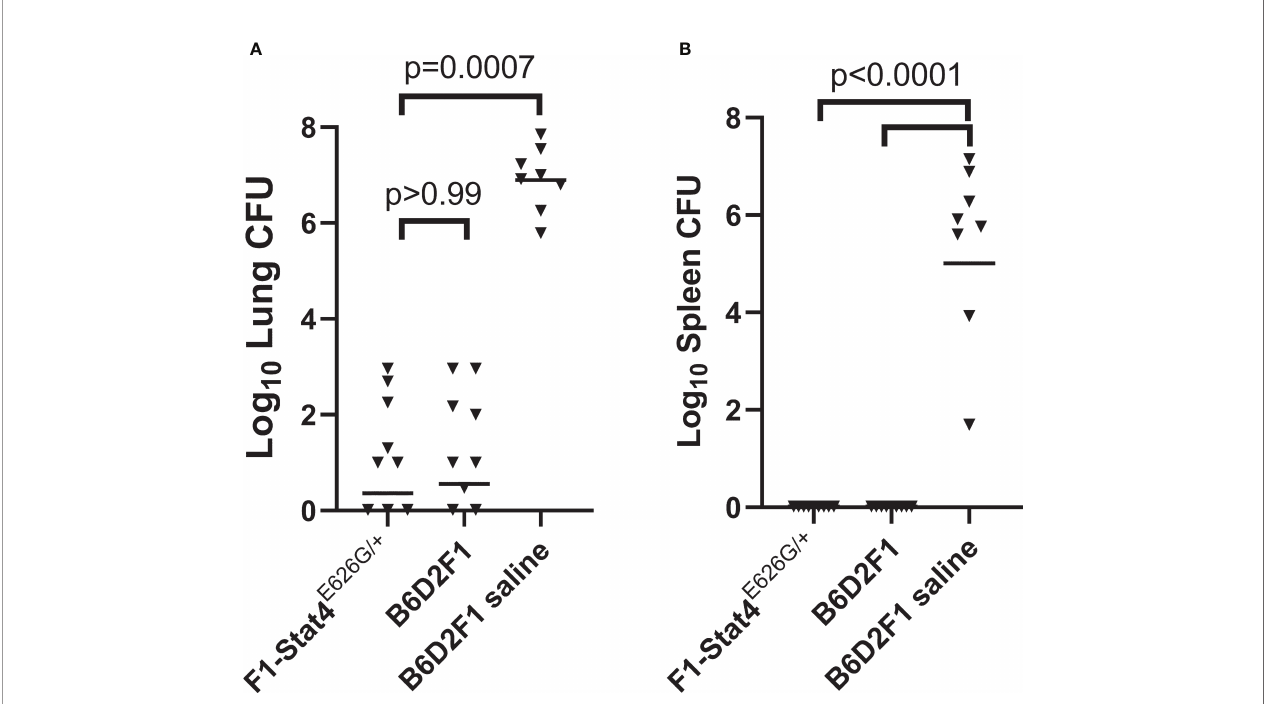
FIGURE 2 | B6D2F1-Stat4 E626G/+ mice vaccinated with D cps1 twice and challenged with lethal C. posadasii Silveira had signi fi cantly reduced lung (A) and spleen (B) fungal burdens 14 days post-infection. They were indistinguishable from normal B6D2F1 mice. Dissemination was prevented in B6D2F1-Stat4 E626G/+ mice while universally present in unvaccinated B6D2F1 mice. (Statistical analysis,